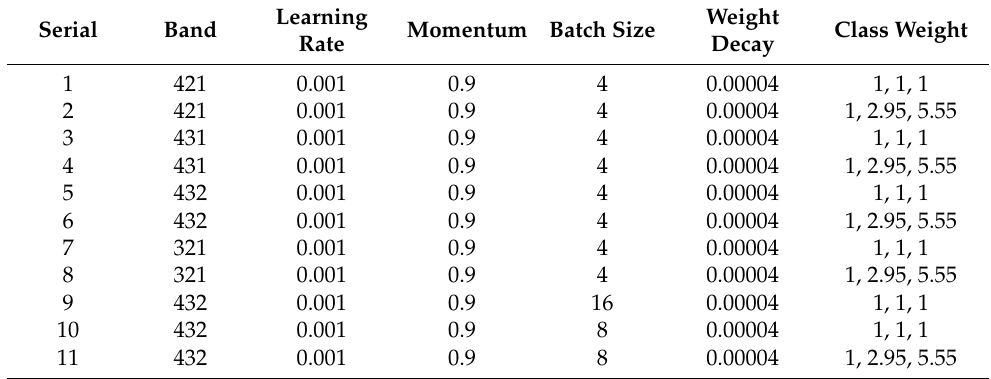
Table 4. The setting of the parameters of